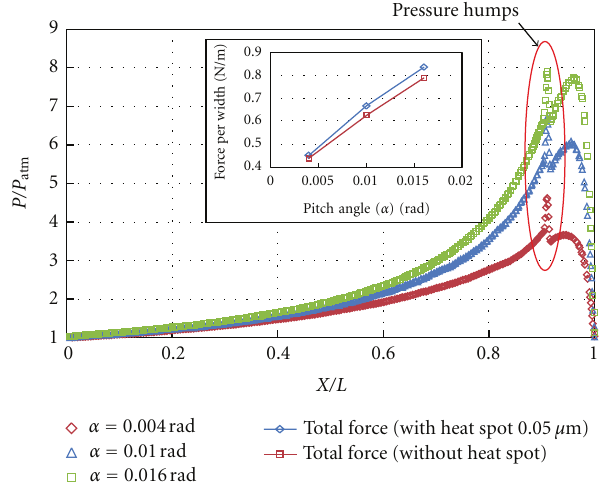
Figure 5: Comparison of air bearing pressure profiles on the slider surface with a 0.05 μ m heated spot on the disk for di ff erent pitching angles and (insert) the comparison of bearing forces at di ff erent pitch angles with a 0.05 μ m heated spot and without a heated